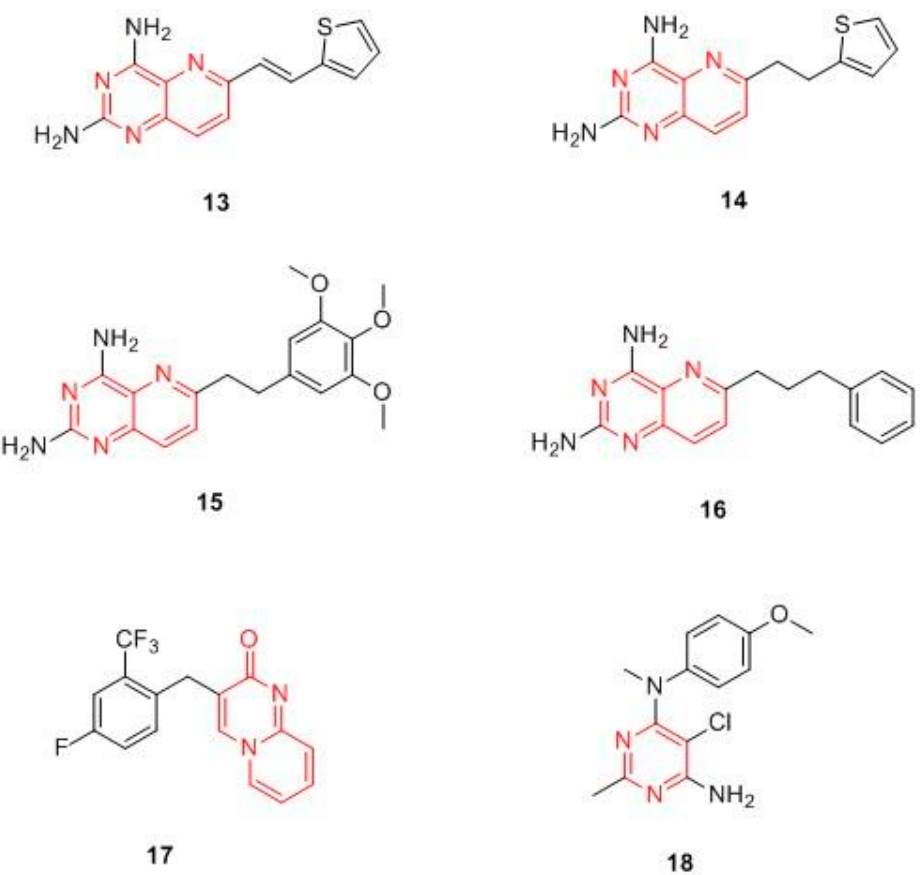
Figure 8. Chemical structures of pyrimidine and pyridopyrimidine hDHFR inhibitors.